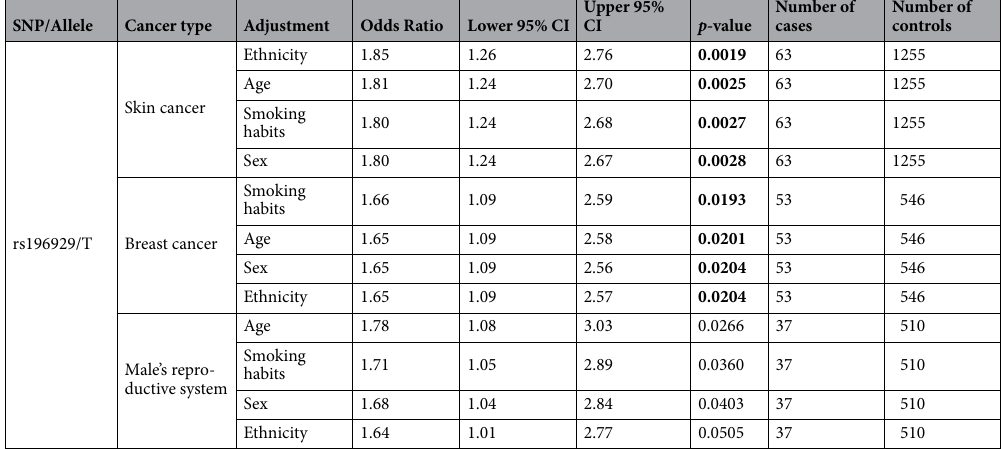
Table 2. Logistic regression analysis of associations between the rs196929 and different types of cancer in patients with tooth loss ( p -values below 0.05). Bold indicates statistically significant associations.